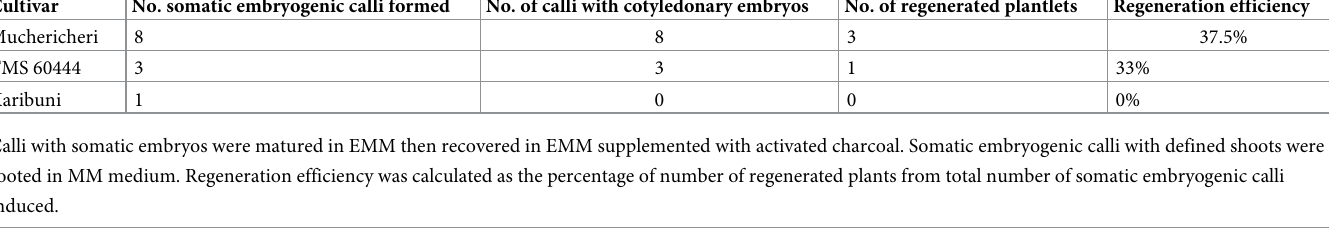
Table 5. Somatic embryo maturation, shoot and root induction. Cultivar No. somatic embryogenic calli